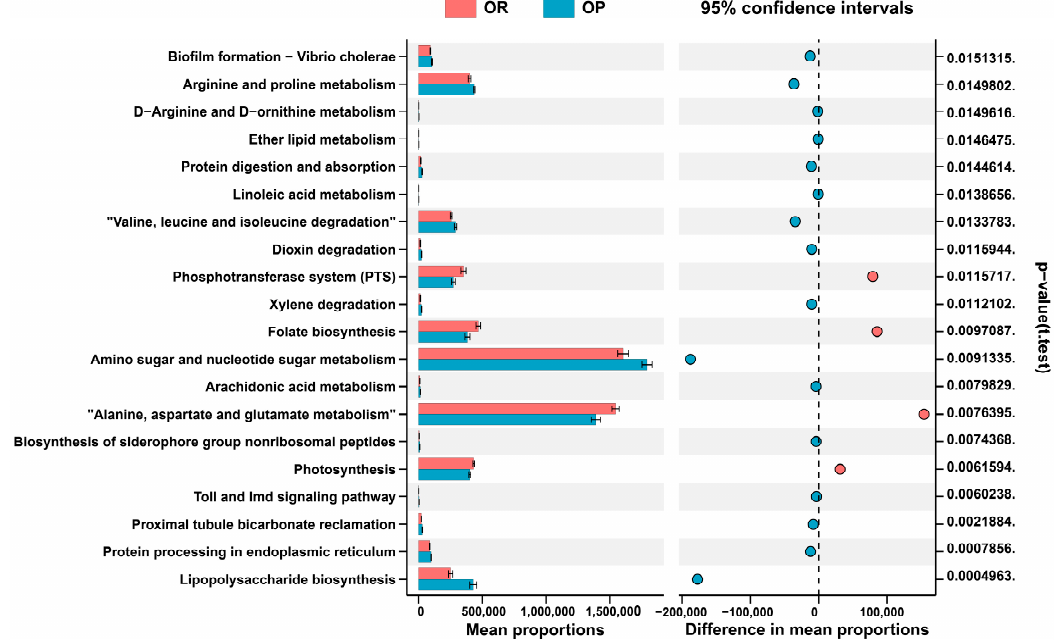
Figure 4. PICRUSt2 analysis predicted metabolic pathways by PICRUSt2 using 16s rRNA gene sequences (Only the first 20 will be displayed). The rightmost is the p -value, and p < 0.05 is statistically significant.